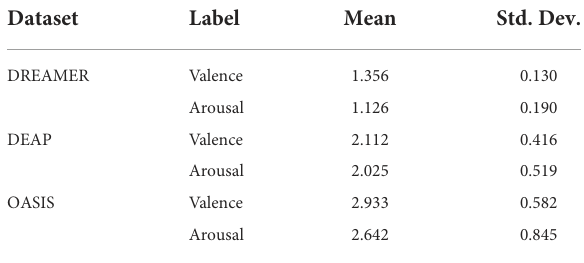
TABLE 6 Mean and standard deviation (Std. Dev.) of RMSE values for valence and arousal label data after leave-one-subject-out-cross-